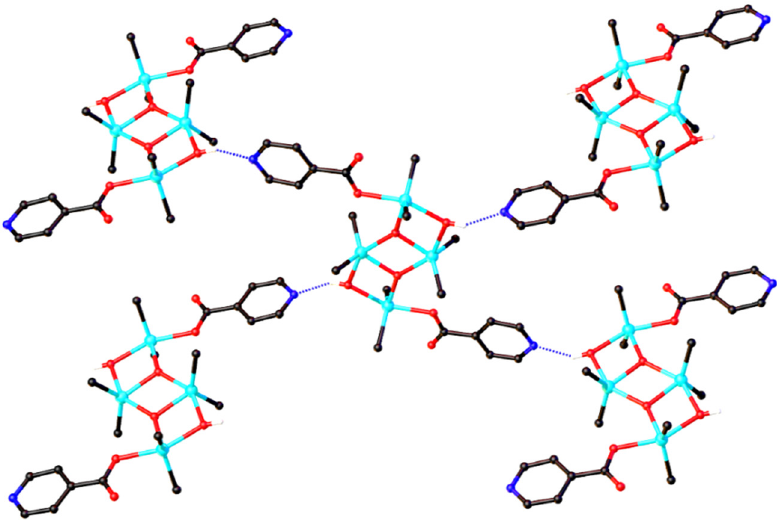
Figure 2: Crystal structure in an in fi nite chain of [ C 5 H 4 N -( p - CO 2 )] 2 [ Bu 2 Sn ] 4 ( μ 3 - O ) 2 ( μ 2 - OH ) 2 ( 1 ) with O – H ⋯ N intermolecular hydrogen bonds. Only C ipso of the n - butyl groups are shown for clarity.